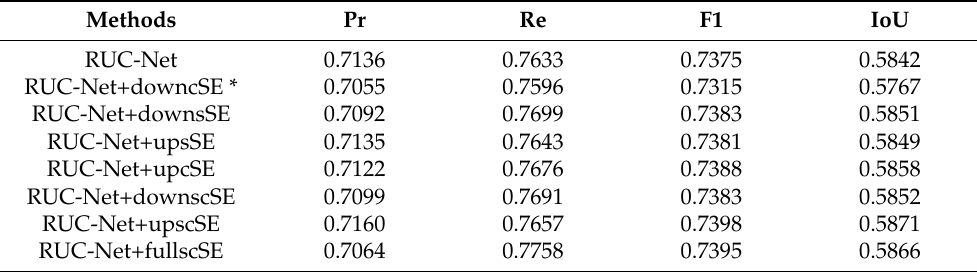
Table 5. The differences of various scSE modules and their combinations in improving the perfor- mance of crack detection taking CFD as an example.